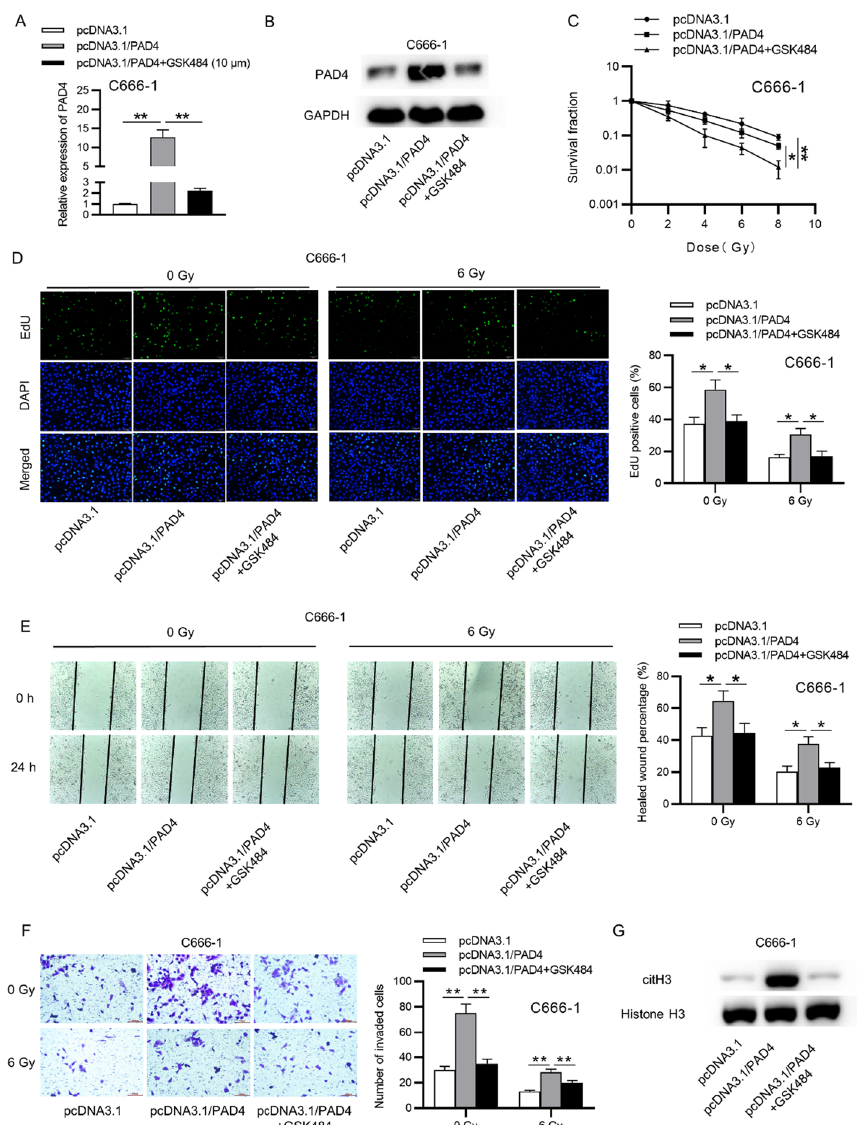
Fig. 4 Treatment of GSK484 attenuates the efect of PAD4 overexpression of NPC cell functions. A , B The PAD4 level in NPC cells treated diferently by RT-qPCR and western blot analyses. C Colony formation assay for the survival of NPC cells treated diferently. D Cell proliferation in NPC cells treated diferently by EdU assay. E , F Migration and invasion ability in NPC cells treated diferently by wound healing and Transwell. G The citH3 protein levels in NPC cell treated diferently by western lot. One-way ANOVA with Tukey’s post hoc test. *p <